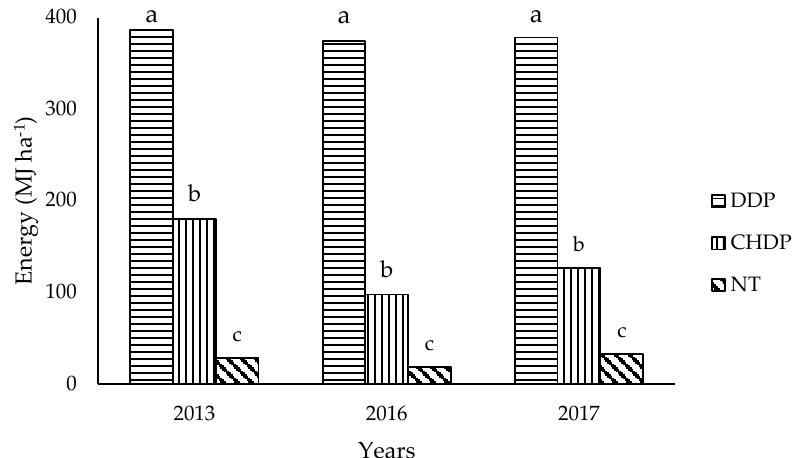
Figure 2. Energy per worked area for each tillage system; different letters in columns in the same year have significant differences (Tukey, α ≤ 0.05).